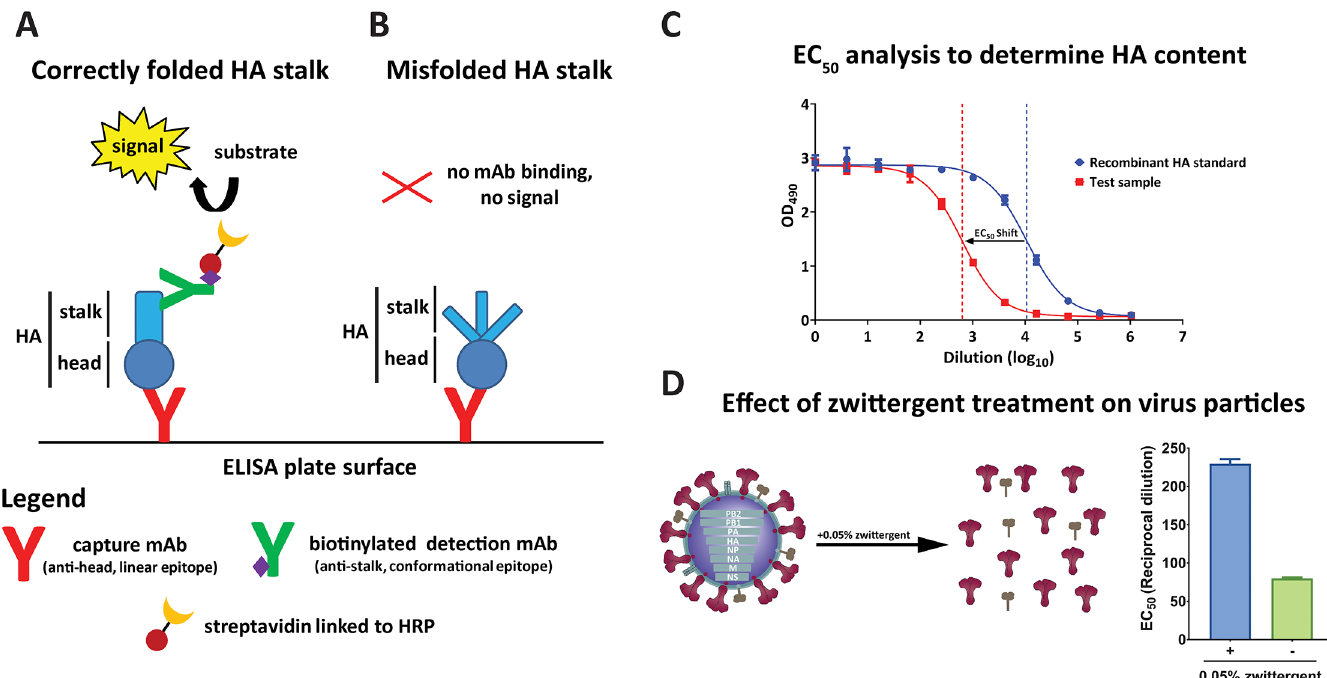
Fig 1. Development of capture ELISA to measure correctly folded HA stalk domain. ( A ) and ( B ) describe the underlying concept of the assay. The assay was primarily developed to detect HA with conformationally intact stalk epitopes. The capture mAb in this assay recognizes the HA head linear epitope. On the other hand, the detection mAb recognizes the conformational epitope in the HA stalk. (A) If the stalk of the HA is properly folded, the detection mAb can bind and thus produces a signal. (B) If the stalk is misfolded, no signal is observed since the detection mAb cannot recognize the HA stalk. (C) HA concentration was calculated using a curve-fit model similar to parallel line analysis in which EC 50 values are used to determine relative amounts. An EC 50 analysis is shown using a recombinant protein standard with a known concentration for reference. The shift in EC 50 between protein standard and test samples was then used to calculate the HA content of test samples. (D) The test samples were treated with 0.05% zwittergent for 1h to solubilize the influenza virus membrane and prevent transmembrane-driven rosette formation. EC 50 values of virus preparations treated with or without zwittergent were calculated. Bars represent mean with error bars representing standard error of the mean.